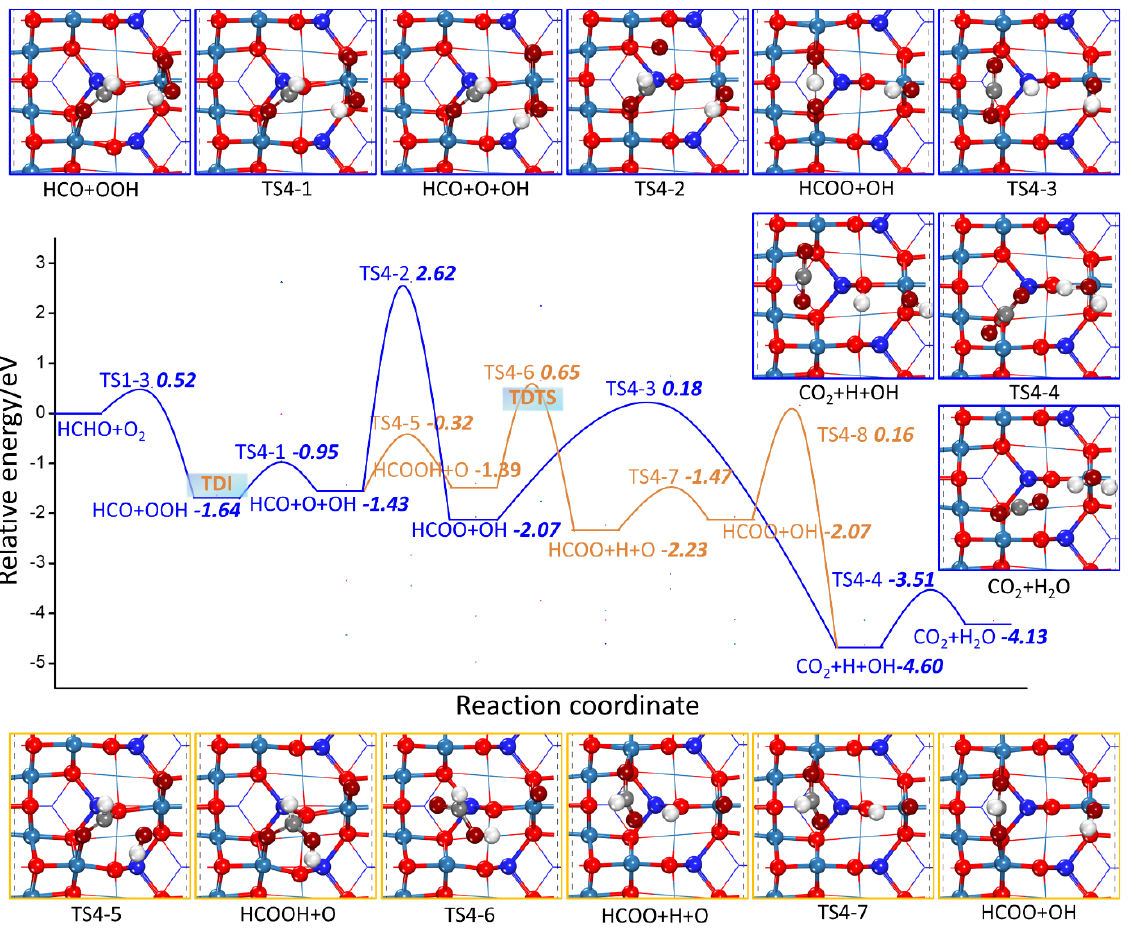
Figure 8. The potential energy profile of HCHO oxidation based on the L-H mechanism through HCO grabbing the surface adsorbed oxygen species together with the structures of TSs and FSs on Co 3 O 4 (110) surface.